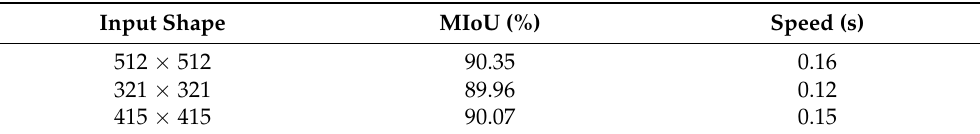
Table 10. Comparison results of different